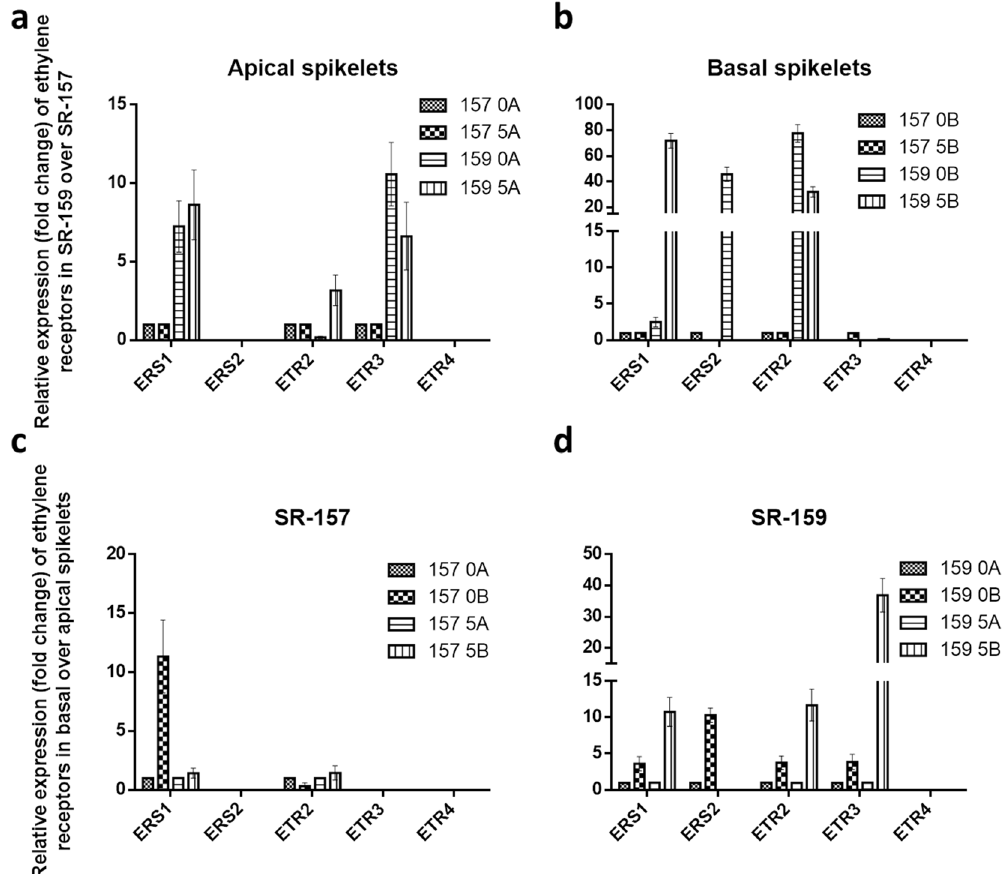
Figure 9. Relative expression (in fold change) of different ethylene signal transducer genes EIN2, EIN3, ERF2, ERF3, EREBP1 and EREBP5 in the apical and basal spikelets of the panicle of high sterile (SR-159) over low sterile (SR-157) rice genotypes and in the basal over apical spikelets SR-157 and SR-159 analysed by Real Time PCR (qRT-PCR). The data are means of three replicates and vertical bars represent ± SD values (n =